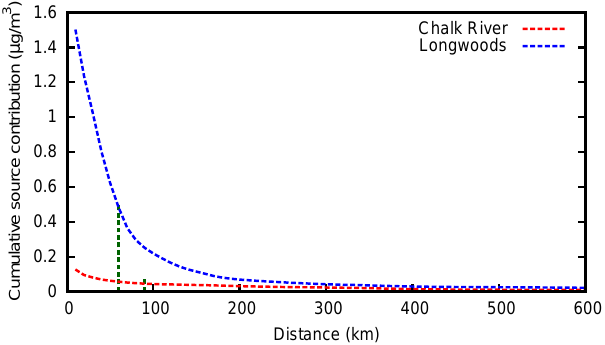
Fig. 8. Simulated cumulative net source contribution of NH 3 as a function of the distances of source areas to Longwoods (blue dashed line) and Chalk River (red dashed line) over the entire simulation period. Green dashed lines show the distances at which cumulative contribution declined to 1/e of the final accumulated source contri- bution within 10 km of the receptor.